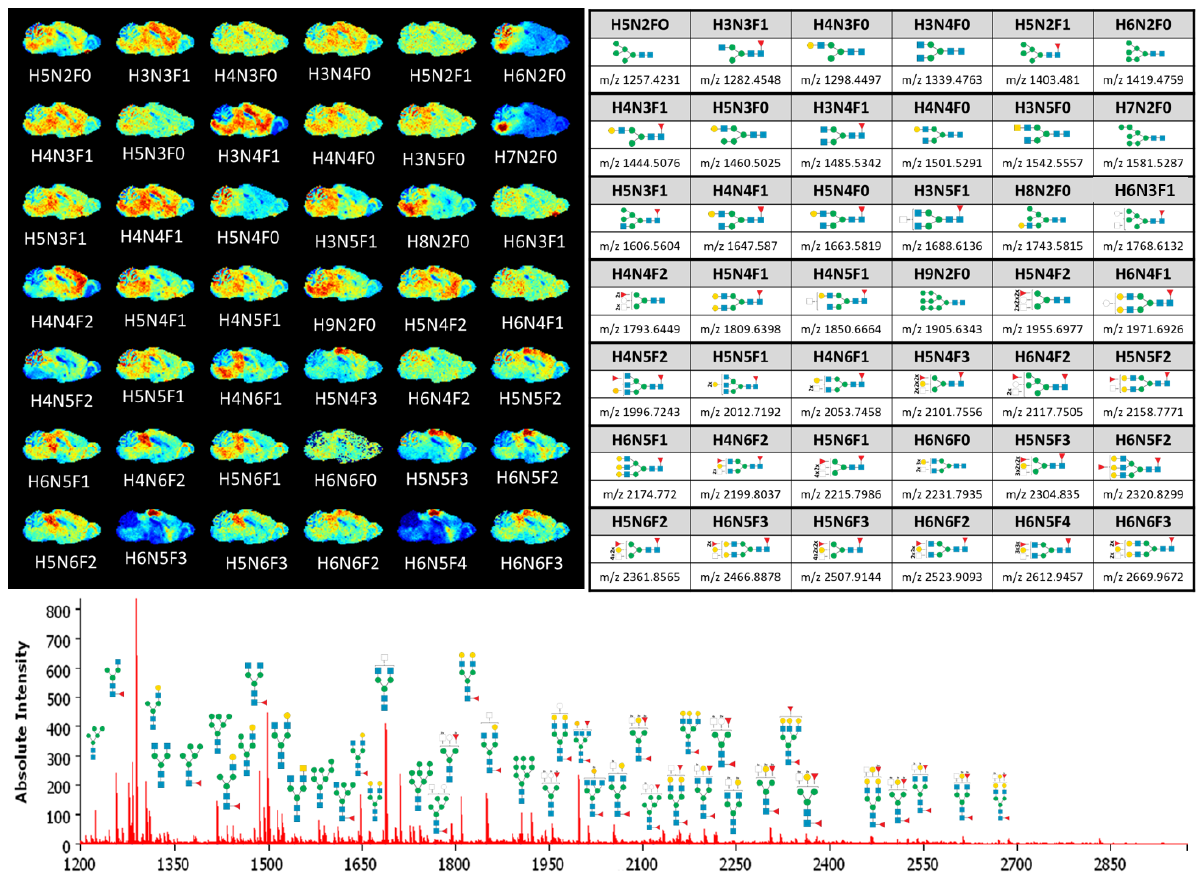
Figure 1. Application of the digestion device-based spatial N -glycan mapping workflow using timsToF flex MSI. Shown are 42 m/z distributions on fresh-frozen (FF) sagittal brain sections ( top left ) of the candidate corresponding N -glycans from a reference list (Toghi Eshgi et al.) [27] ( top right ). H indicates the number of hexoses, N the number of N-acetylhexosamines and F the number of fucoses in the carbohydrate moiety. The lower mass spectrum shows the absolute intensity distri- bution of the corresponding m/z values represented in the MS Image.